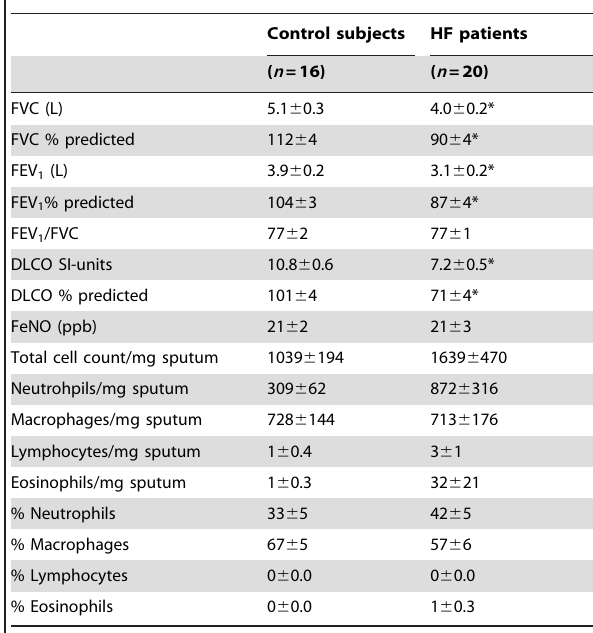
Table 2. Lung function, exhaled NO value and differential sputum cell count in the induced sputum